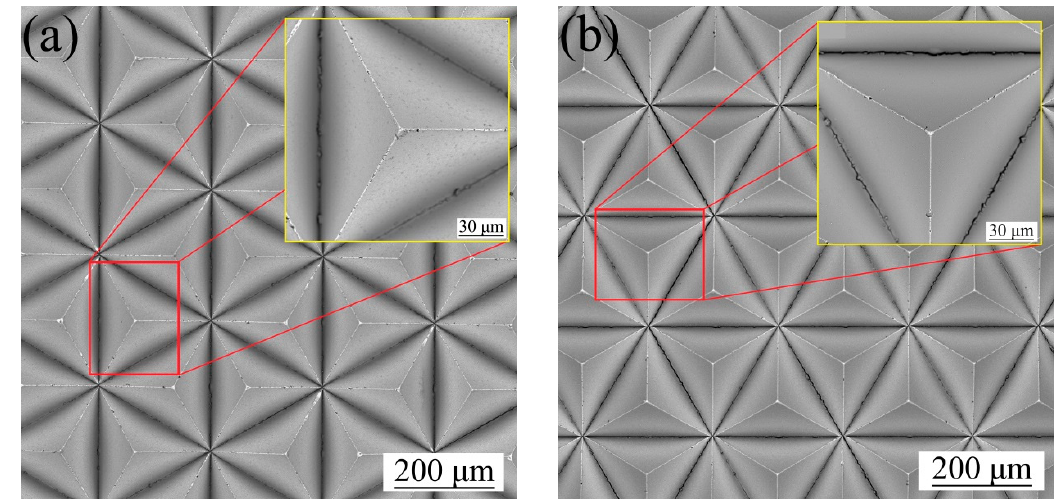
Figure 3. The surface morphology of original mold: ( a ) scheme 1; ( b ) scheme 2.